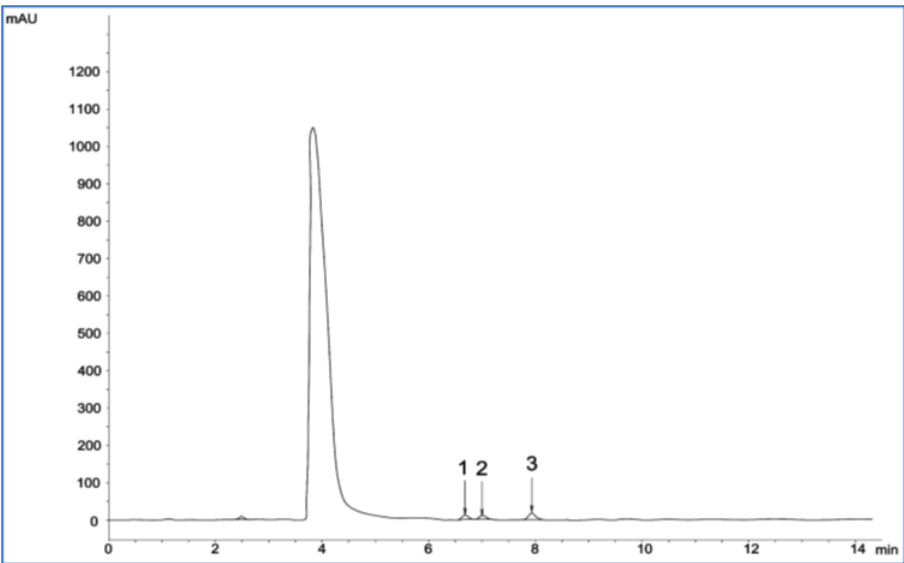
Figure 2. Reducing sugars (fructose, glucose, and saccharose as Peaks 1, 2, and 3, respectively) detected in the aqueous extract of okra pods by high-performance liquid chromatography.